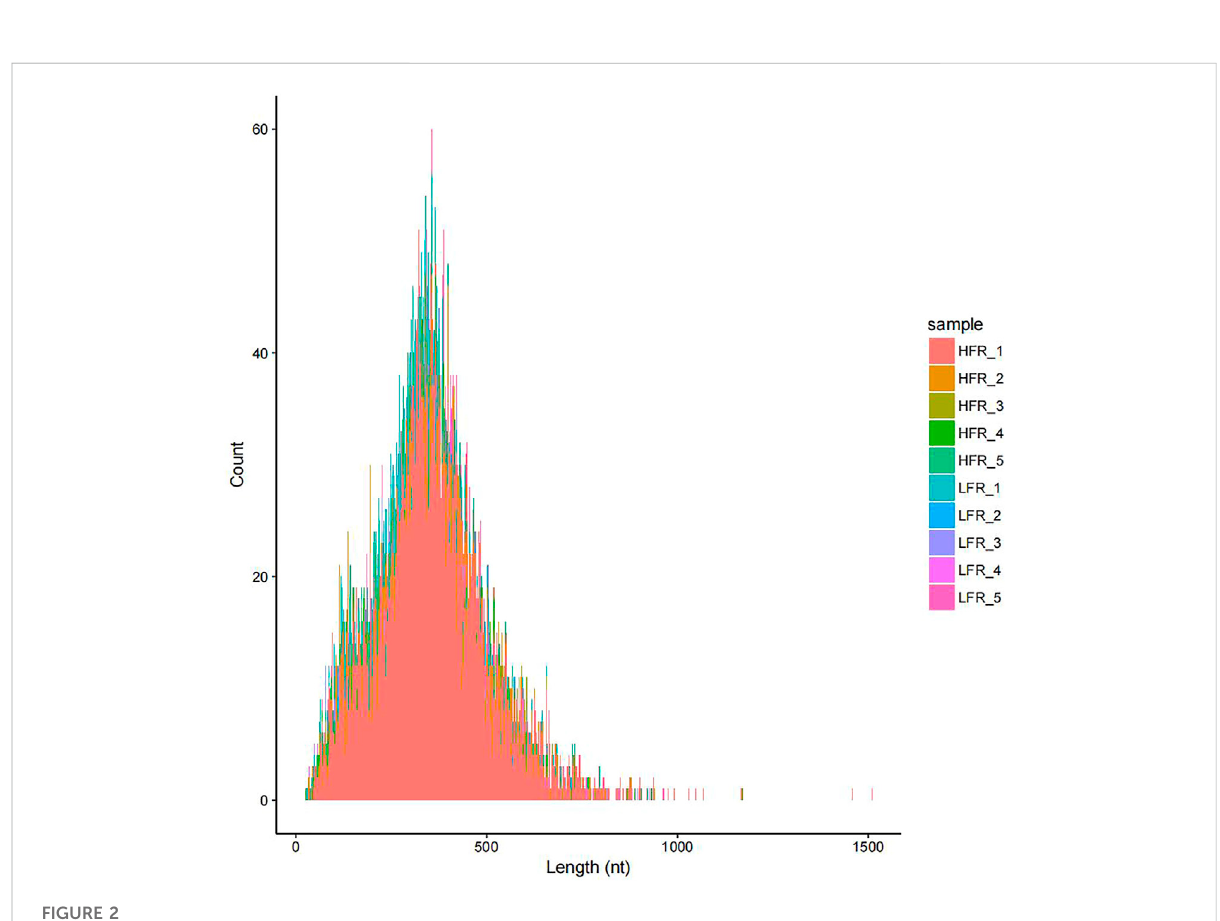
FIGURE 2 Length distribution of